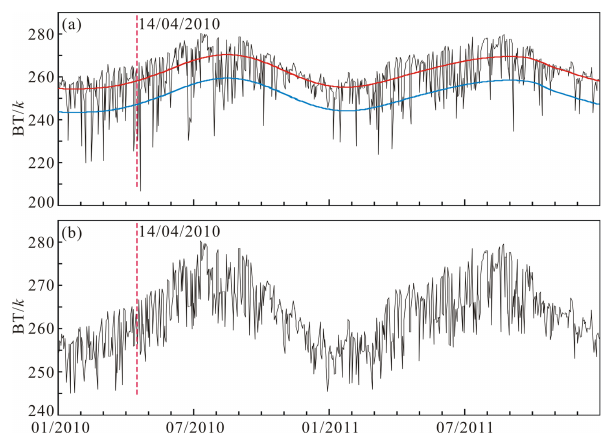
Fig. 2. (a) The raw brightness temperature data of one pixel (5km × 5km resolution) was located at 31.8 ◦ N, 96.3 ◦ E from 1 January 2010 to 31 December 2011. The red solid line is trend component of raw temperature. Blue solid line is 1.5 times mean variance threshold. Temperature below the blue line is seen as cloud-top temperature and is substituted with temperature of the red line on the same date. (b) Brightness temperature series after cloud elimination. The high power caused by sharp variations of low cloud-top temperature in power spectrum analysis is removed after cloud elimination. Temperature increase before earthquake of- ten lasts longer than short-time fluctuations. Thus, their power could possibly be presented at different